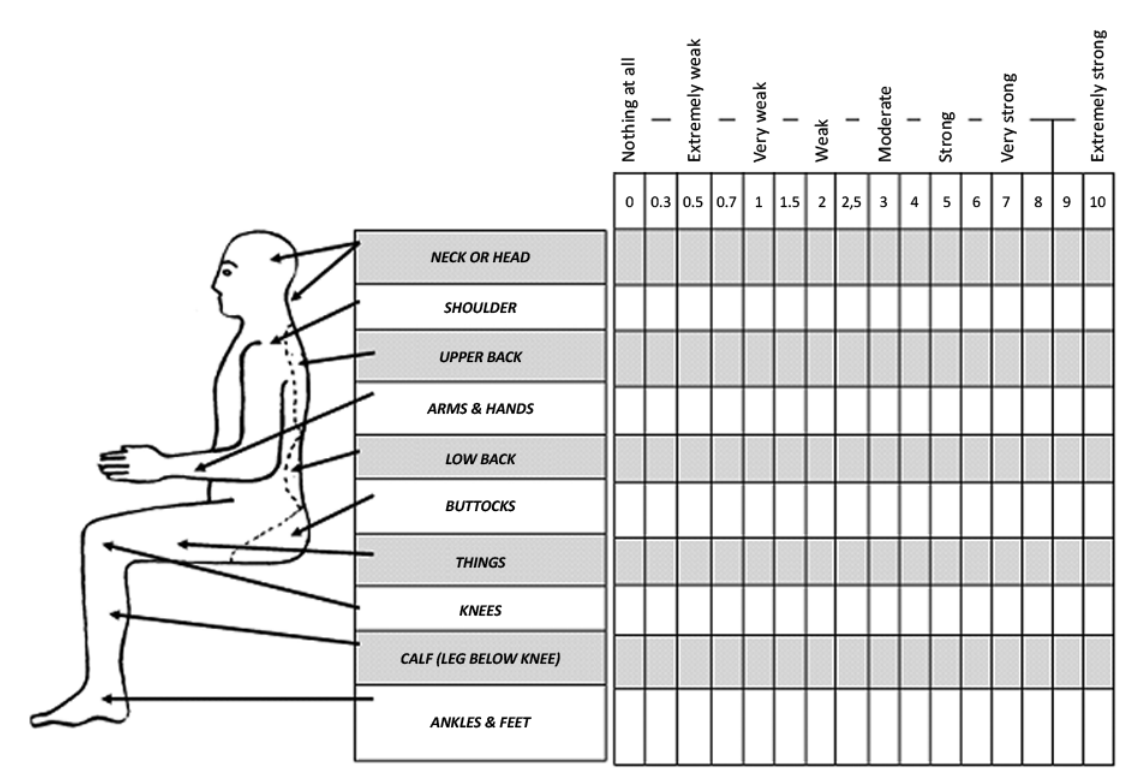
Figure 2 - The body chart discomfort using Borg’s CR-10